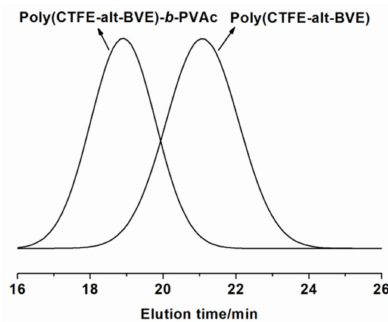
Figure 4. GPC traces of poly(CTFE-alt-BVE) (Sample P4, M n,GPC = 10900, M w / M n = 1.37) and poly(CTFE-alt-BVE)- b -PVAc ( M n,GPC = 17200, M w / M n =